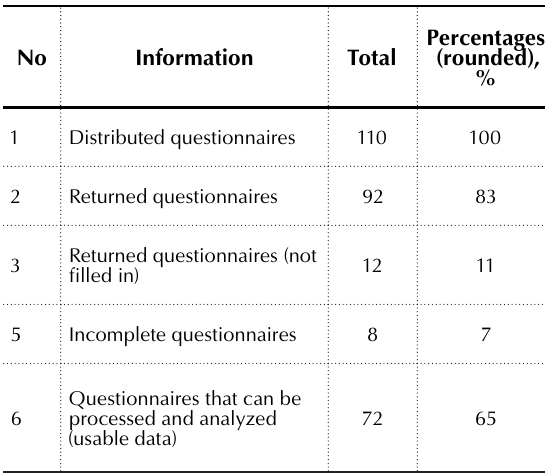
Table 1. Percentage of distributed and